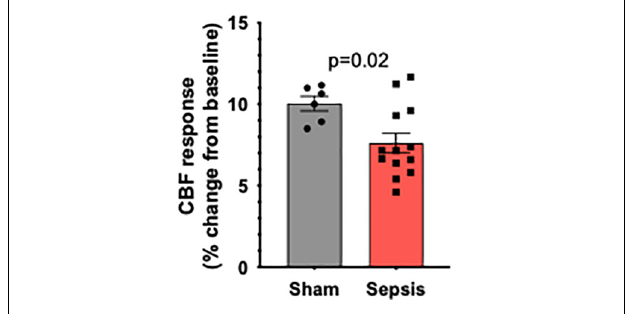
FIGURE 2 | Sepsis impairs NVC responses in aged animals. Sepsis ( n = 13) significantly impaired CBF responses during whisker stimulation when compared to sham controls ( n = 7). Data are presented as a%-change from baseline values prior to sham or l. monocytogenes treatment. p = 0.002.